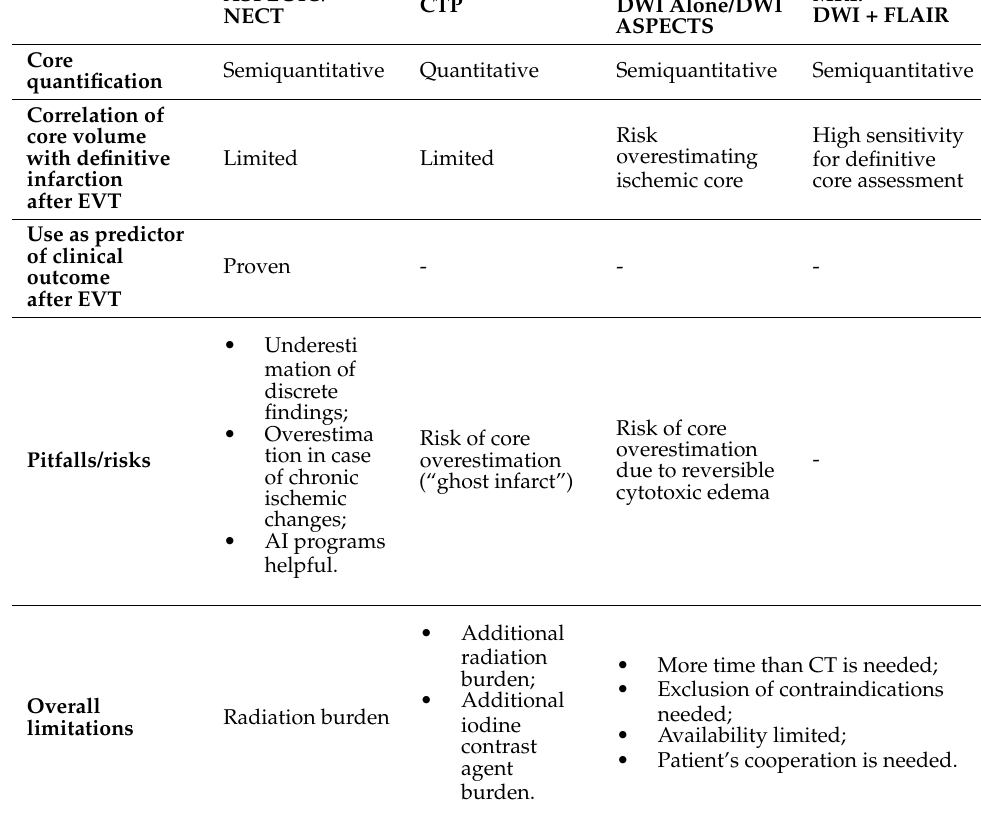
MRI: ASPECTS/ CTP DWI NECT